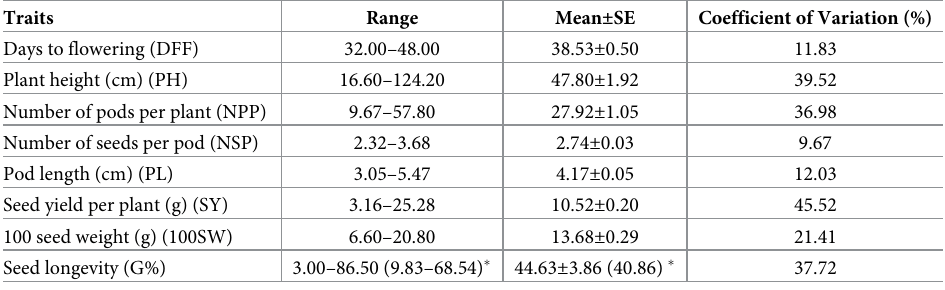
Table 5. Mean, range and coefficient of variation (CV %) of genotypes for eight quantitative traits.